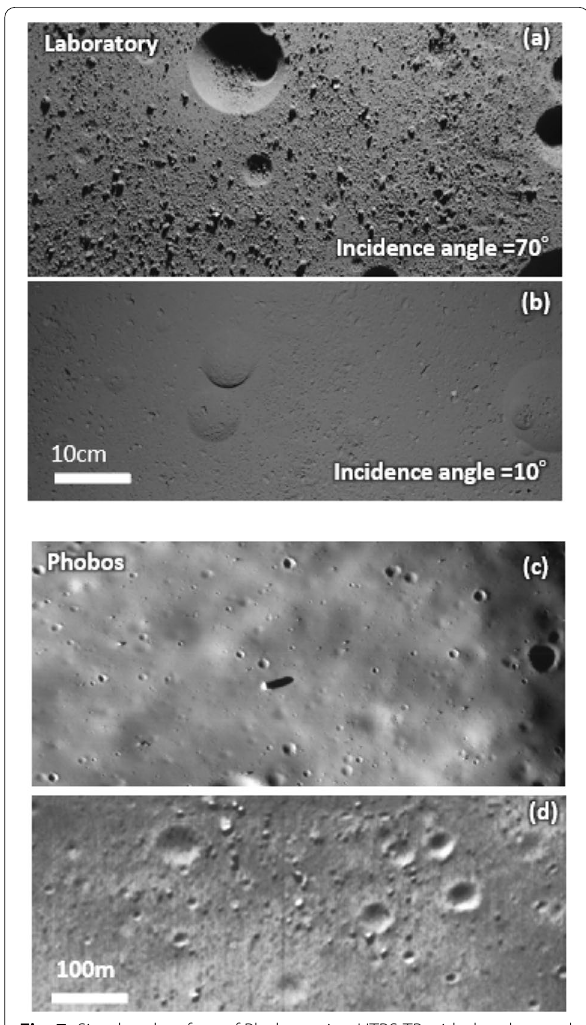
Fig. 7 Simulated surface of Phobos using UTPS‑TB with the observed crater size‑frequency distributions and incidence angles of 70 degrees ( a ) and 10 degrees ( b ). Close‑up views of Phobos’ surface ( c , d ; parts of MGS Mars Orbiter camera image